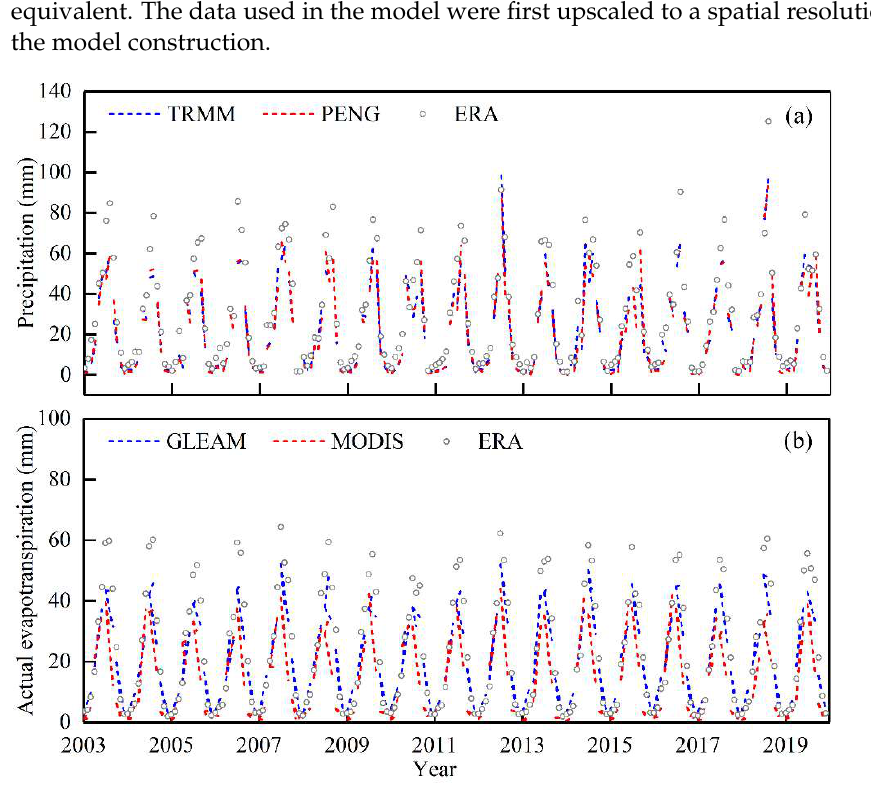
Figure 2. Comparison of different precipitation and actual evapotranspiration data sources in SRB from 2003 to 2019: ( a ) monthly precipitation; ( b ) actual evapotranspiration.